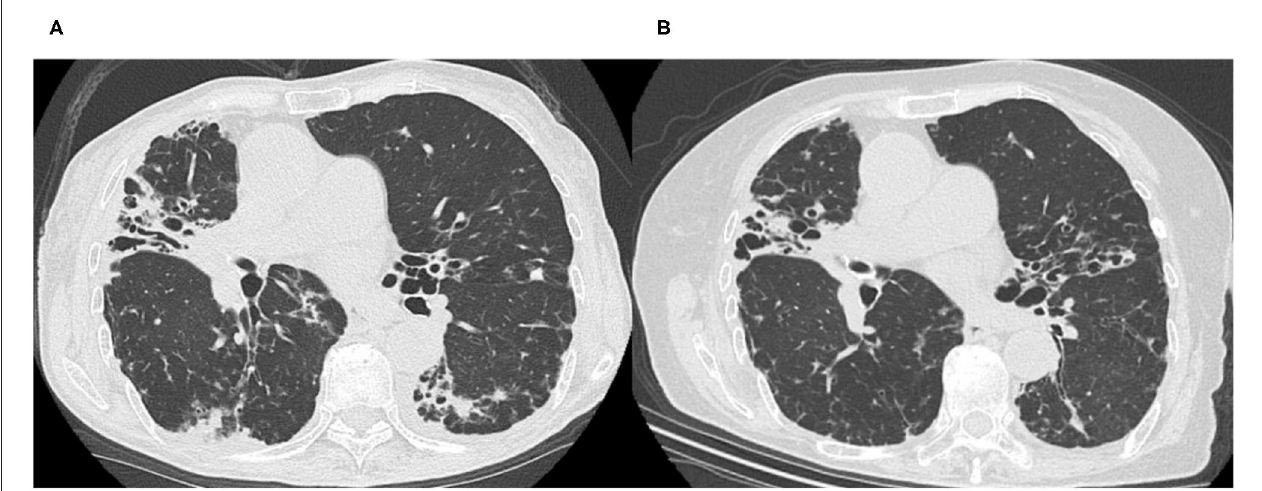
FIGURE 1 | High-resolution computed tomography images before (A) and after (B) bukuryoshigyakuto treatment. (A) The image taken at the first visit at our hospital in 2015 showed middle lobe and lingular segment predominant bronchiectasis, bilateral centrilobular lesions, and dorsal predominant bronchiolitis. (B) In 2018, bilateral centrilobular lesions, consolidation, and dorsal predominant bronchiolitis lesions were improved, though the middle lobe and lingular segment bronchiectasis had no change.